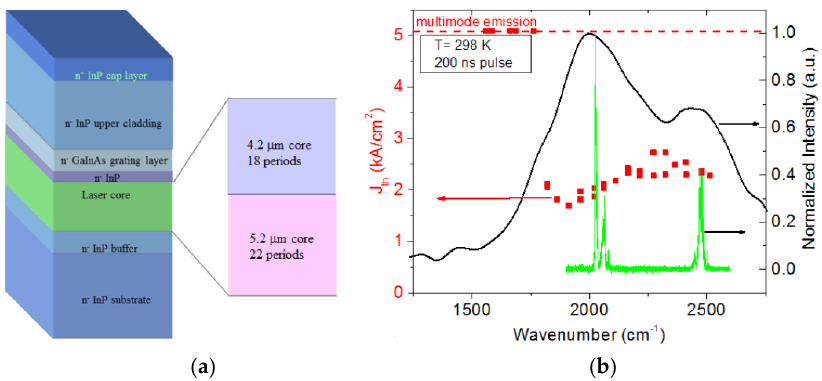
Figure 2 . ( a ) Schematic layer structure of dual core mid-wavelength infrared (MWIR) QCL; ( b ) Right axis: Normalized electroluminescence and Fabry Perot laser emission from the dual core wafer. Left axis: Threshold current density of DFB lasers according to targeted emission wavenumber. Points at the top left represent DFB lasers which exhibit only multimode emission.